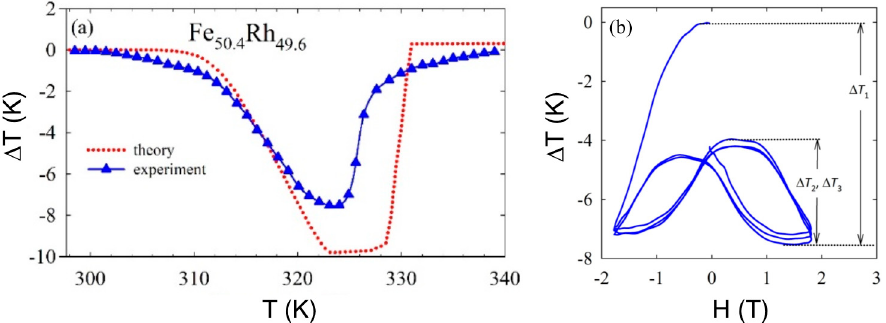
Figure 5. ( a ) Theoretical and experimental Δ T ( T ) at 1.8 Tesla for the first magnetic field cycle ( H = 0 → +1.8 T → 0 → -1.8 T → 0) versus initial temperature T , and ( b ) experimental Δ T ( H ) at 324 K for three T → 0 →− 1.8 T → 0) versus initial temperature T , and ( b ) experimental ∆ T ( H ) at 324 K for three cycles of cycles of magnetization/demagnetization in the Fe 50.4 Rh 49.6 sample. Data is from [337]. magnetization / demagnetization in the Fe 50.4 Rh 49.6 sample. Data is from [337].